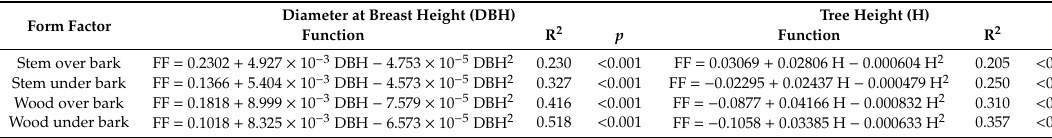
Table 1. Functions for estimating form factors using diameter and